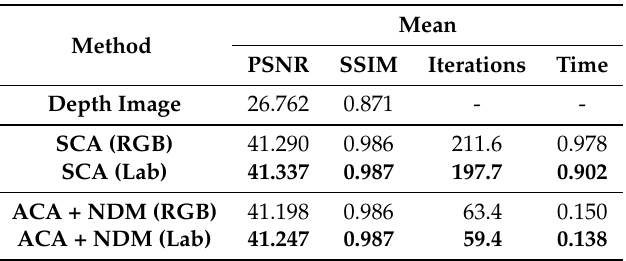
Table 7. Comparison of quantitative evaluation results for color space on the entire Tsukuba Stereo Dataset. The best performance is highlighted in